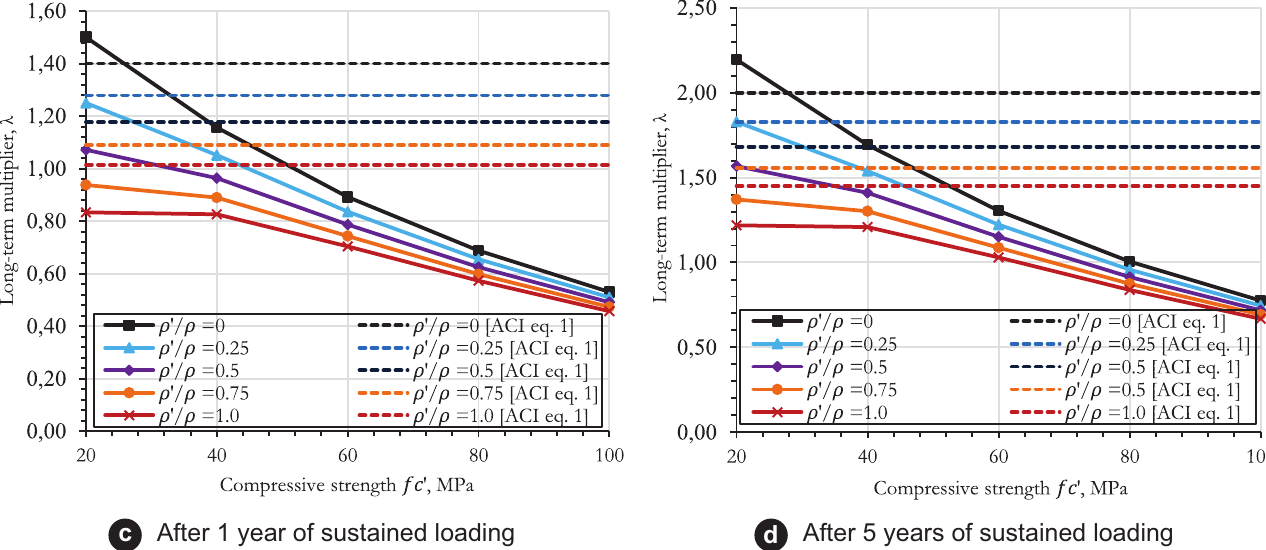
c After 1 year of sustained loading d After 5 years of sustained